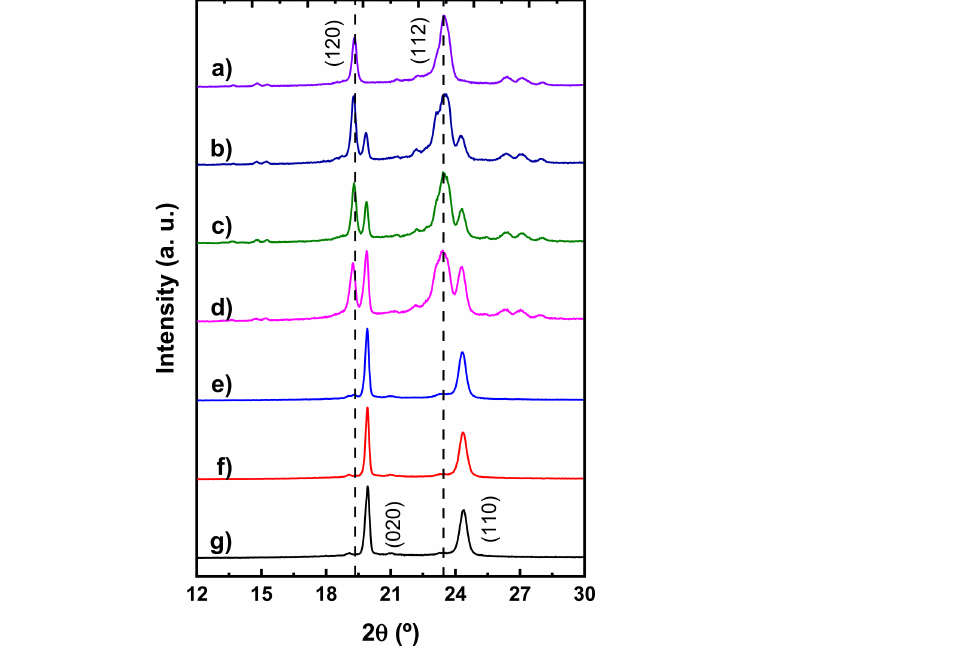
Figure 2. WAXS diffractograms of PEO/PHD blends. ( a ) Neat PEO, ( b ) 80/20 PEO/PHD, ( c ) 60/40 PEO/PHD, ( d ) 50/50 PEO/PHD, ( e ) 40/60 PEO/PHD, ( f ) 20/80 PEO/PHD, ( g ) Neat